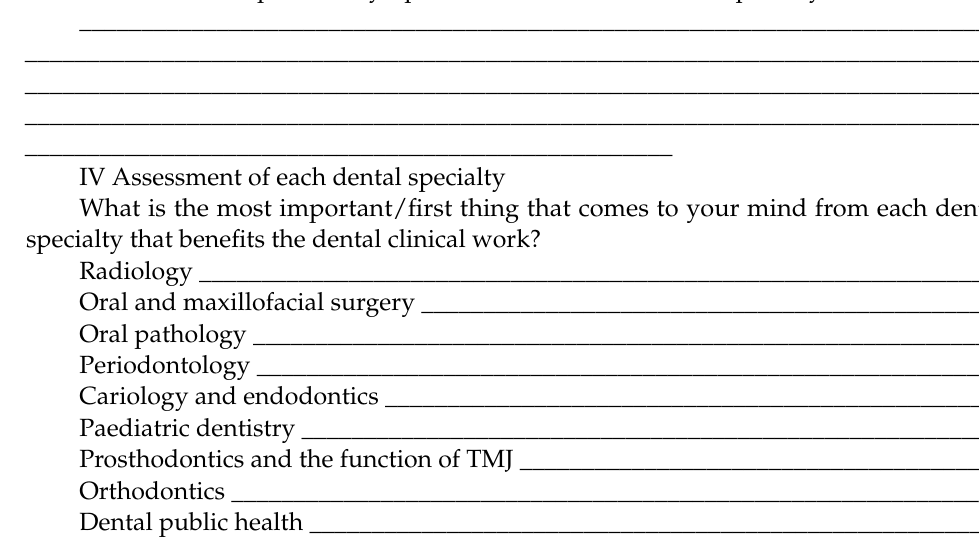
Table A5. V How has the learning of the following areas been implemented in the curriculum? What do you think